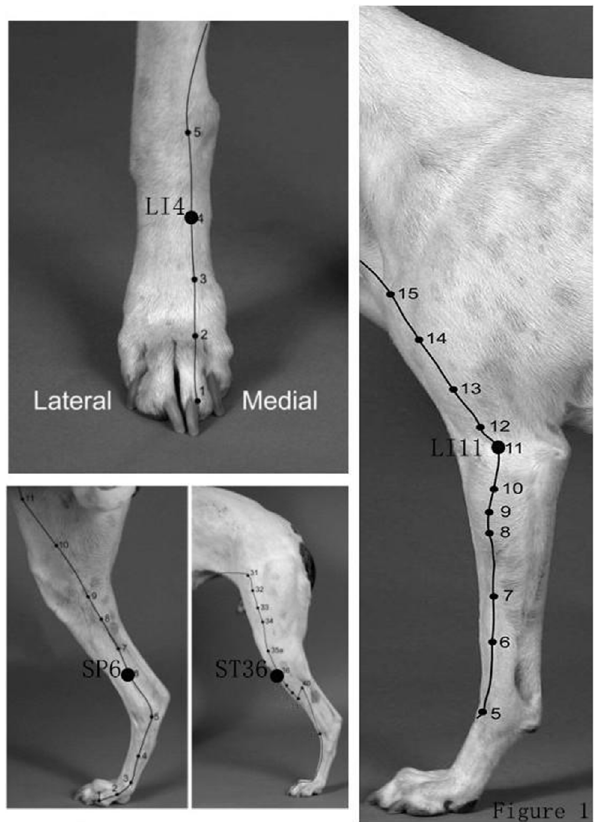
Figure 1. The location of all four acupuncture points. Hegu (LI 4) is on the medial side of the thoracic limb between the second and third metacarpal bones at the midpoint of the third metacarpal bone. Quchi (LI 11) is on the lateral side of the thoracic limb at the lateral end of the cubital crease, halfway between the lateral epicondyle of the humerus and the biceps tendon with the elbow flexed. Sanyinjiao (SP 6) is On the medial side of the pelvic limb 3 cun proximal to the tip of the medial malleolus in a small depression on the caudal border of the tibia (opposite GB-39 on the lateral side). Zusanli (ST 36) is on the craniolateral aspect of the pelvic limb, 3 cun distal to ST-35, 0.5 cun lateral to the cranial aspect of the tibial crest, in the belly of the cranial tibialis muscle; this is a long linear point.